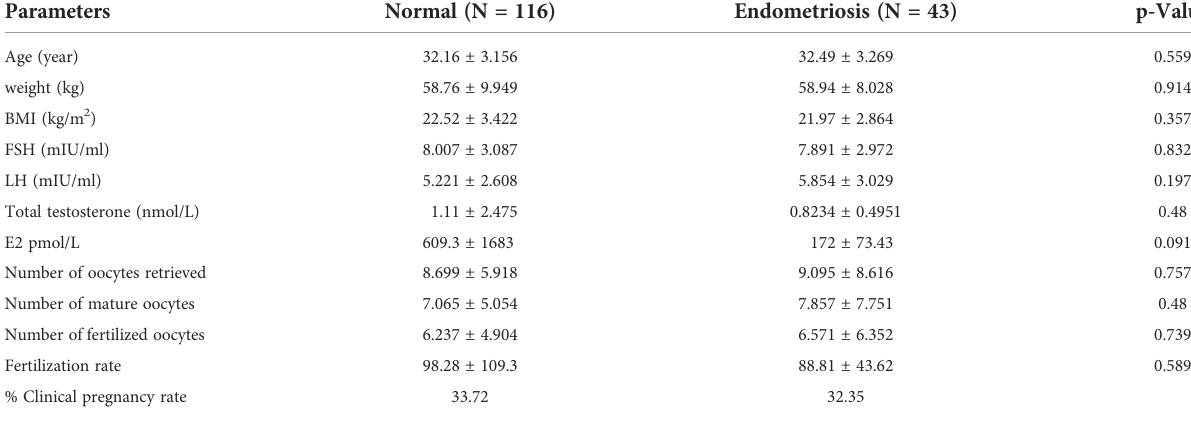
TABLE 2 Clinical characteristics of study participants.